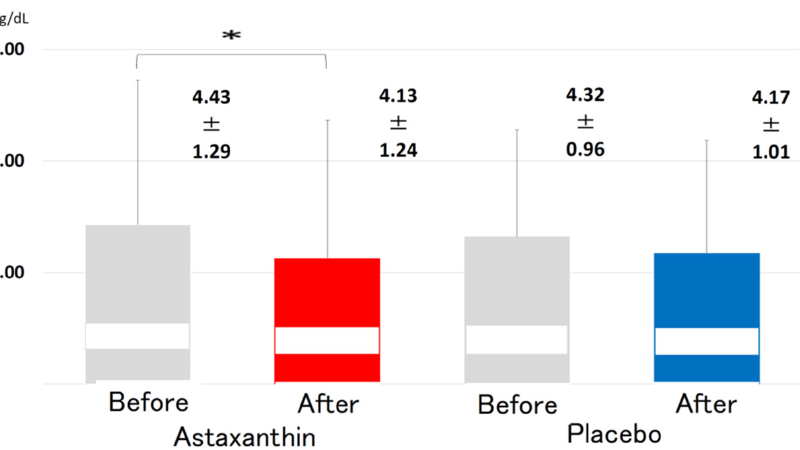
Figure 5. Changes in the serum levels of apo-E before and after supplementation with 12 mg ASTX for 12 weeks. All data are presented as the mean ± standard deviation. The Wilcoxon signed-rank test was used to test for significant differences within each group. *: p < 0.05.